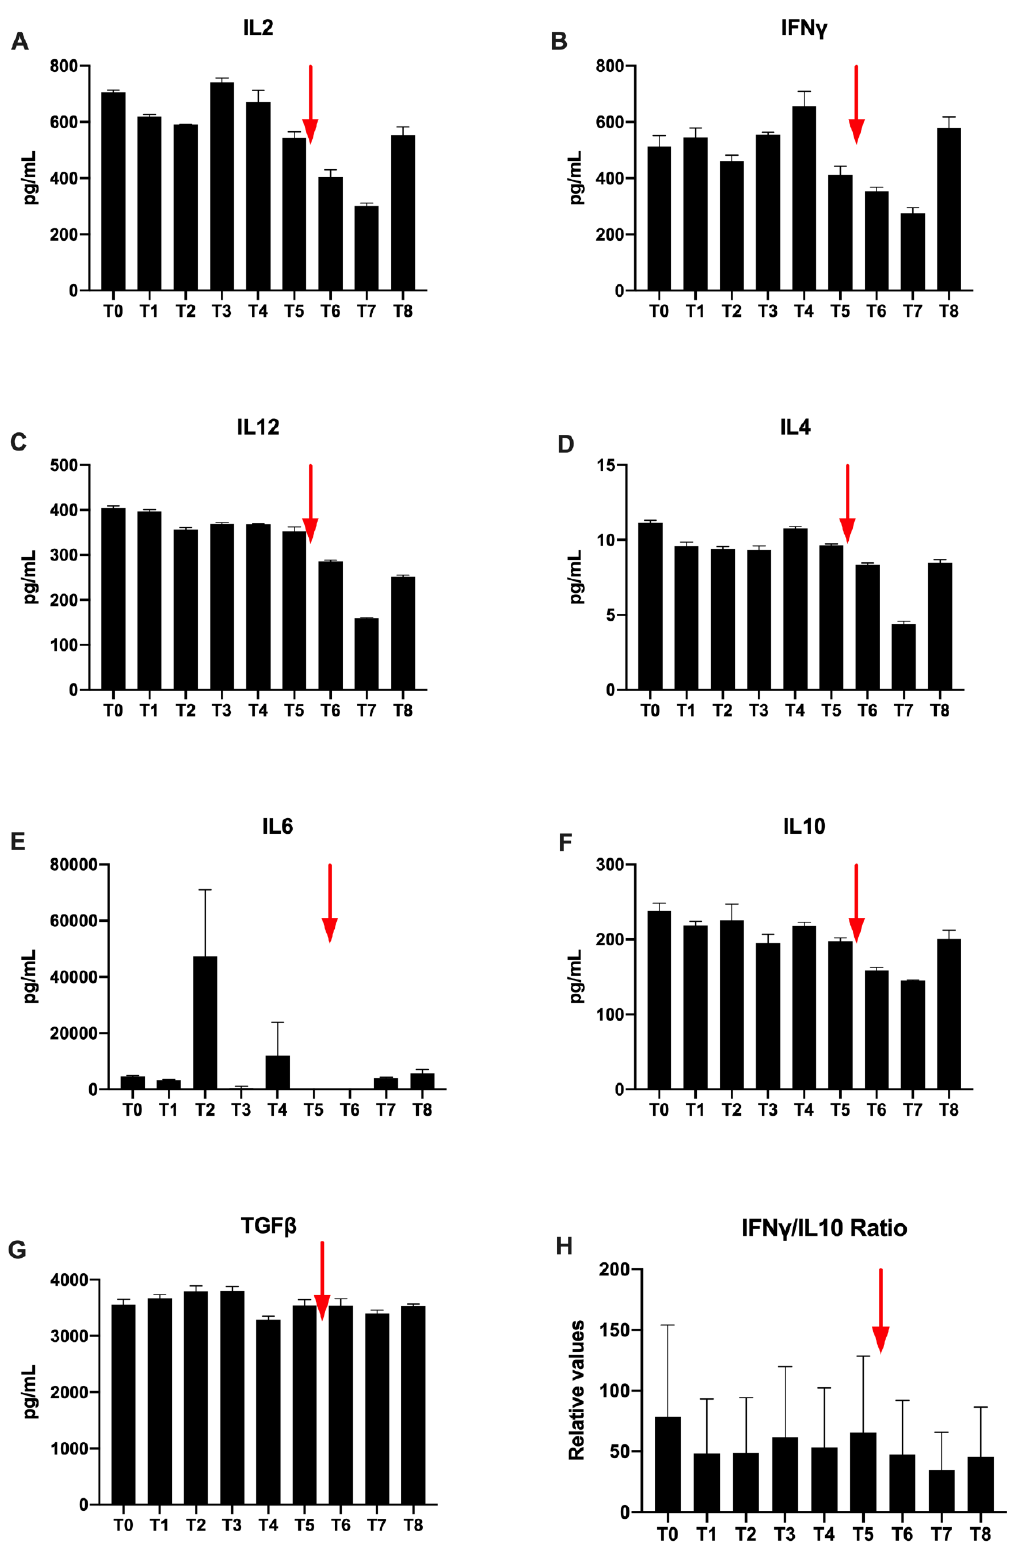
Figure 7. Secretion of IL2 ( A ), IFN γ ( B ) and IL12 ( C ) Th1 cytokines, IL4 ( D ) and IL6 ( E ) Th2 cytokines and IL10 ( F ) and TGF β ( G ) immunosuppressive cytokines in patient’s sera. represented in pg / mL. Representation of IFN γ / IL10 ratio (relative values) ( H ). The time of the Nivolumab single dose injection is represented by the red arrow.